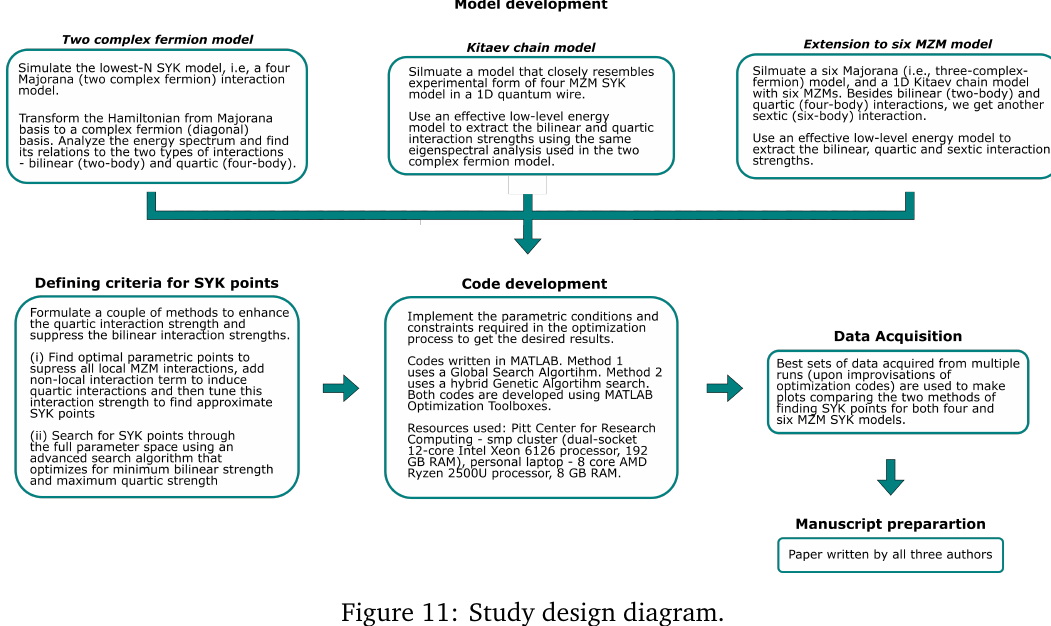
Figure 11: Study design